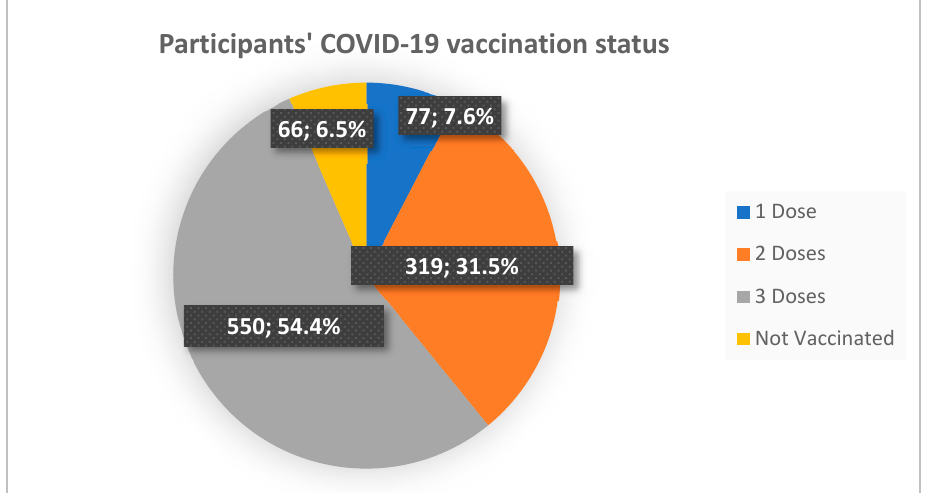
Figure 1. COVID-19 vaccination status of the 1012 study participants.